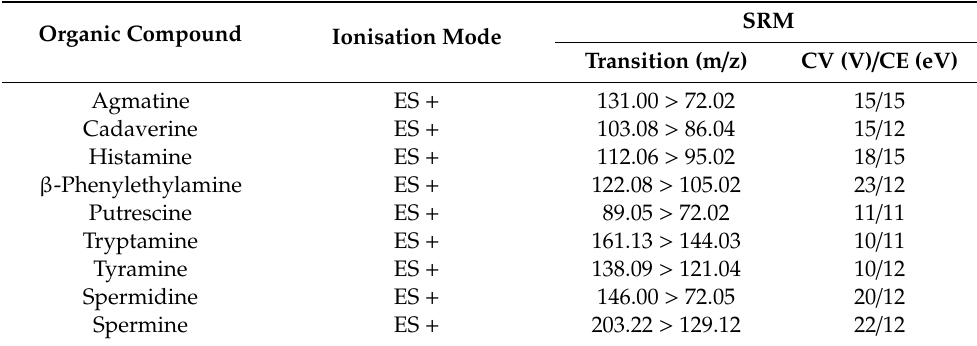
Table 1. Selected reaction monitoring (SRM) transition (m / z), cone voltage (CV), and collision energy (CE) for the organic compounds measured by ultra-high-performance liquid chromatography coupled to tandem mass spectrometry (UPLC-MS /